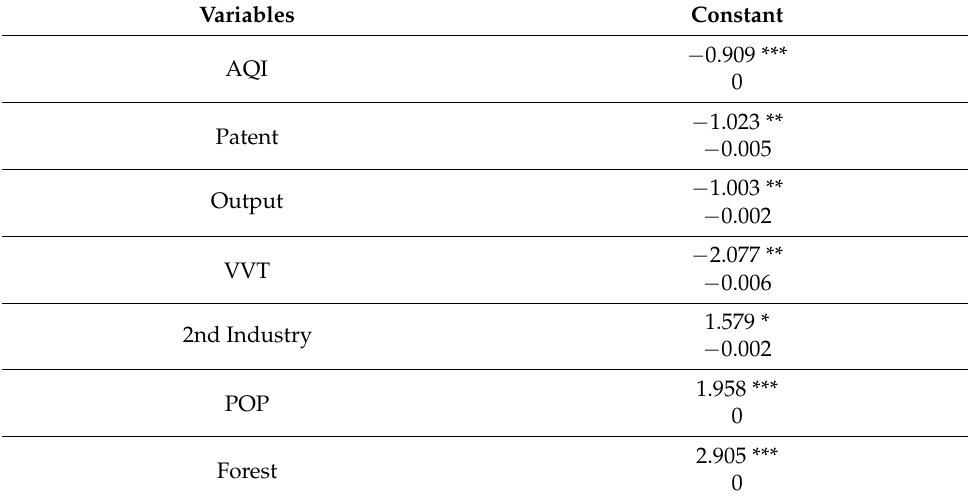
Table 3. Breitung panel unit root tests.